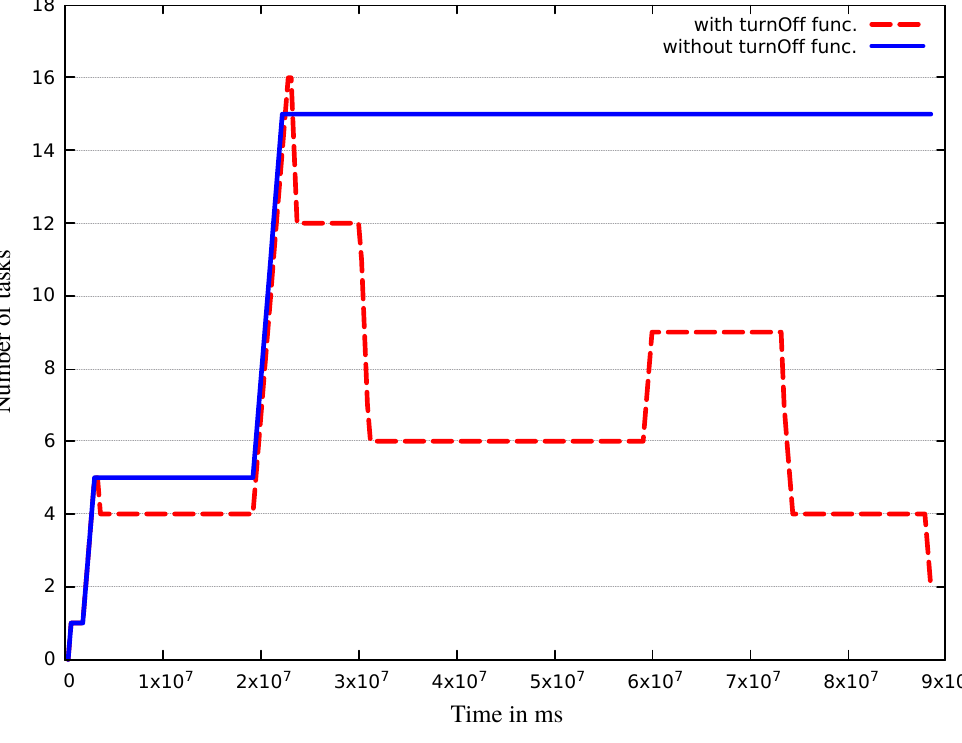
Figure 18. Results of scenario N o 5. Table 6. Cloud and IoT costs in scenario N o